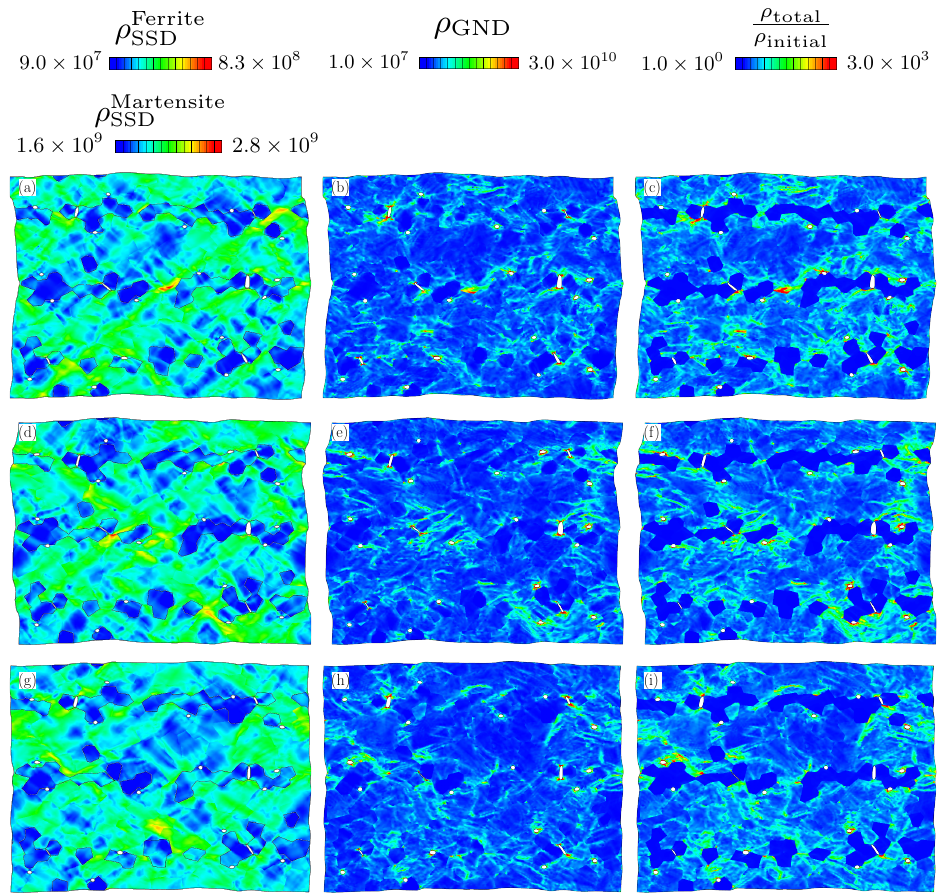
Figure 6. Distribution of ( a , d , g ) ρ SSD (mm − 2 ), ( b , e , h ) ρ GND (mm − 2 ), ( c , f , i ) Normalized dislocation density for banded morphology. Three rows represent 3 different orientation